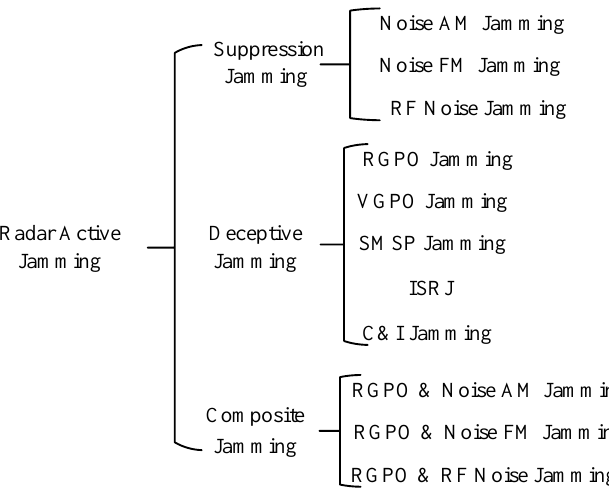
Figure 1. 11 types of jamming signals.